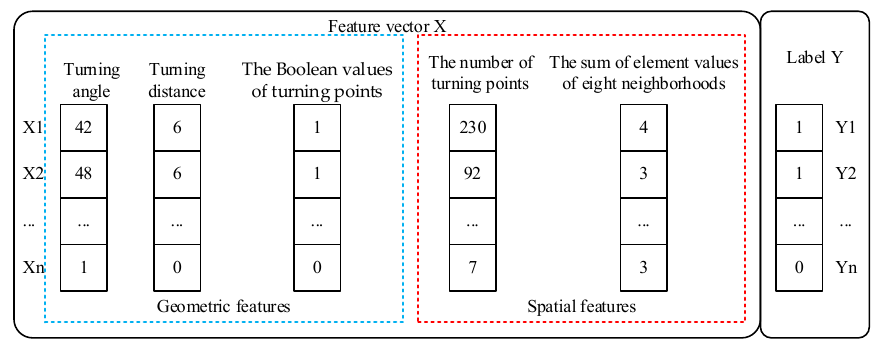
spatial features, and the labels.